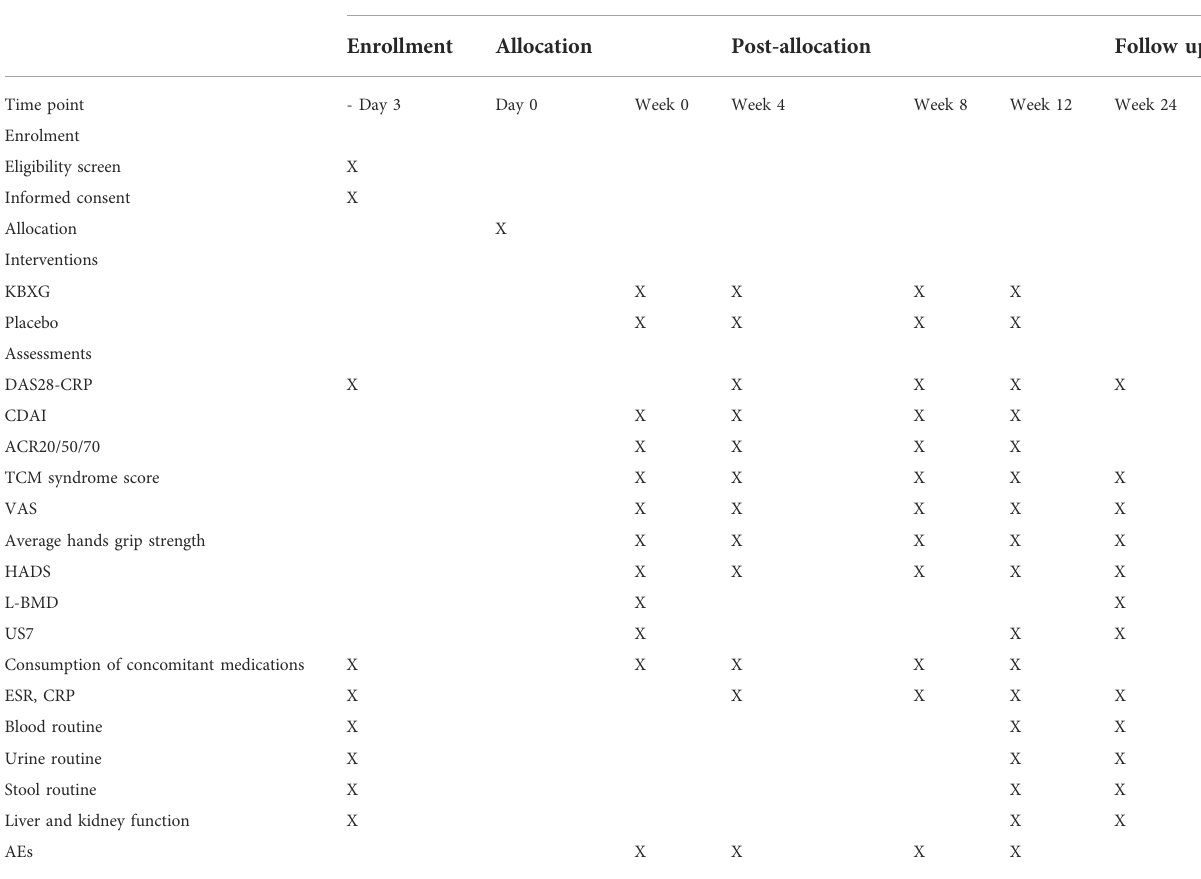
TABLE 2 A standard protocol items: recommendation for interventions for trials